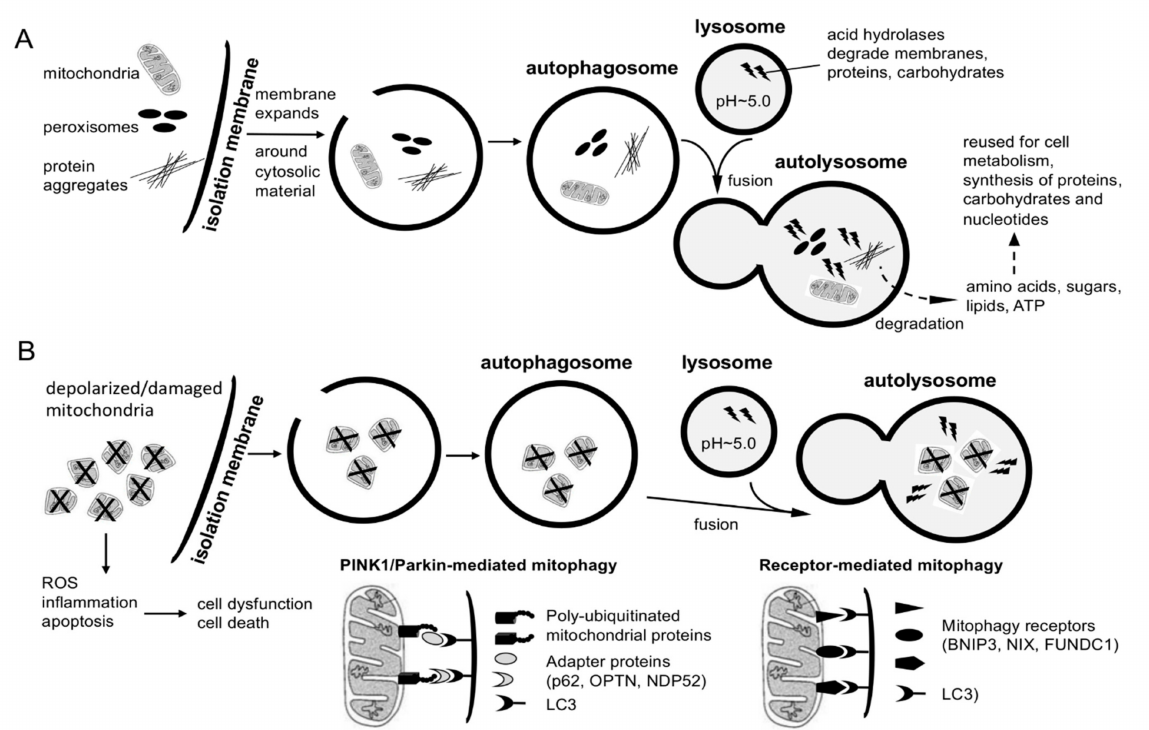
Figure 2. Simplified scheme of autophagy and mitophagy pathways. ( A ) Basal macro-autophagy (autophagy) degrades and recycles cellular contents at steady state. The activity of autophagy is regulated by nutrient (e.g., glucose) and energy (AMP/ATP ratio) availability through PI3K/Akt signaling, mTORC1, and AMPK. Autophagy is induced under conditions of nutrient and energy starvation and by oxidative stress, i.e., conditions that require enhanced recycling of cellular materials to sustain cell metabolism and degradation of oxidized and aggregated proteins to protect cells against stress-induced damage. At the start of autophagy, a double membrane (isolation membrane or phagophore) forms and expands around the cellular material to engulf the material within an autophagosome. The autophagosome fuses with a lysosome that contains hydrolases necessary to degrade the contents within the resulting autolysosome. For details, including stage-specific autophagy regulators, please refer to [96]. ( B ) Mitophagy is a subclass of autophagy that selectively degrades depolarized and damaged mitochondria. There are two mitophagy mechanisms (for details, see [55,68]). In PINK1/Parkin-dependent mitophagy, PINK1 selectively accumulates on depolarized mitochondria (due to import deficiency), and PINK1 and Parkin cooperate to poly-ubiquitinate specific proteins at the surface of depolarized mitochondria. PINK1-phosphorylated polyubiquitin serves a signal for autophagy adapters (p62, OPTN, NDP52) to bind to the damaged mitochondria and target them to autophagosomes via interaction with LC3 of the isolation membrane. In receptor-mediated mitophagy, mitophagy receptors (BNIP3, NIX, FUNDC1) localize to the mitochondrial membrane and directly interact with